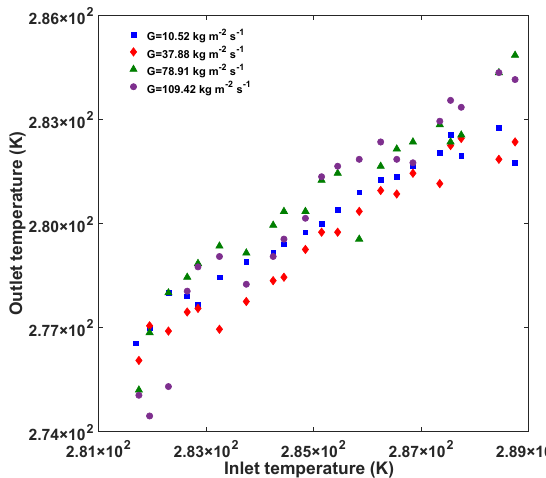
Figure 3. The outlet temperature of the R22 versus the inlet temperature under a diverse mass flux for p = 0.65 MPa.